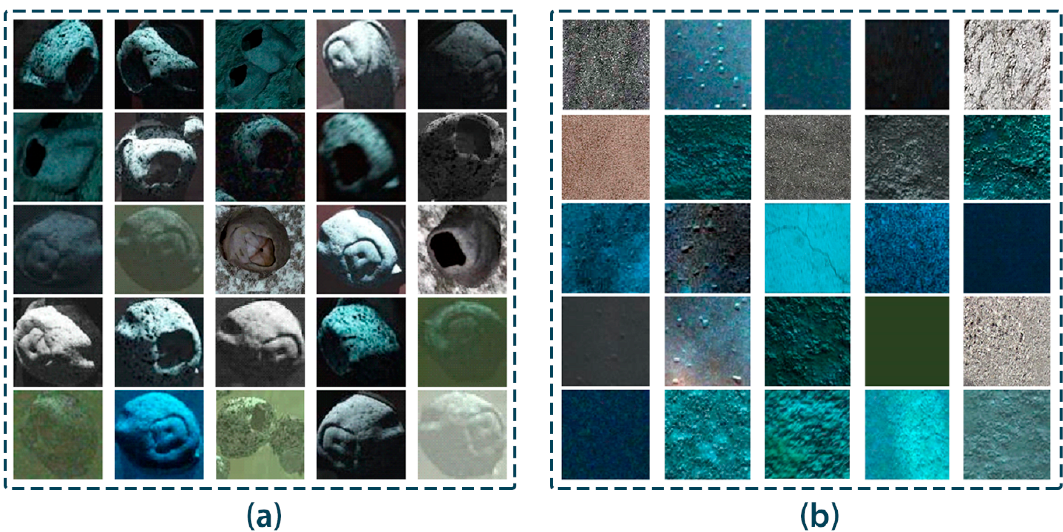
Figure 7. A selection of training images for ( a ) the barnacle class, and ( b ) the background class.